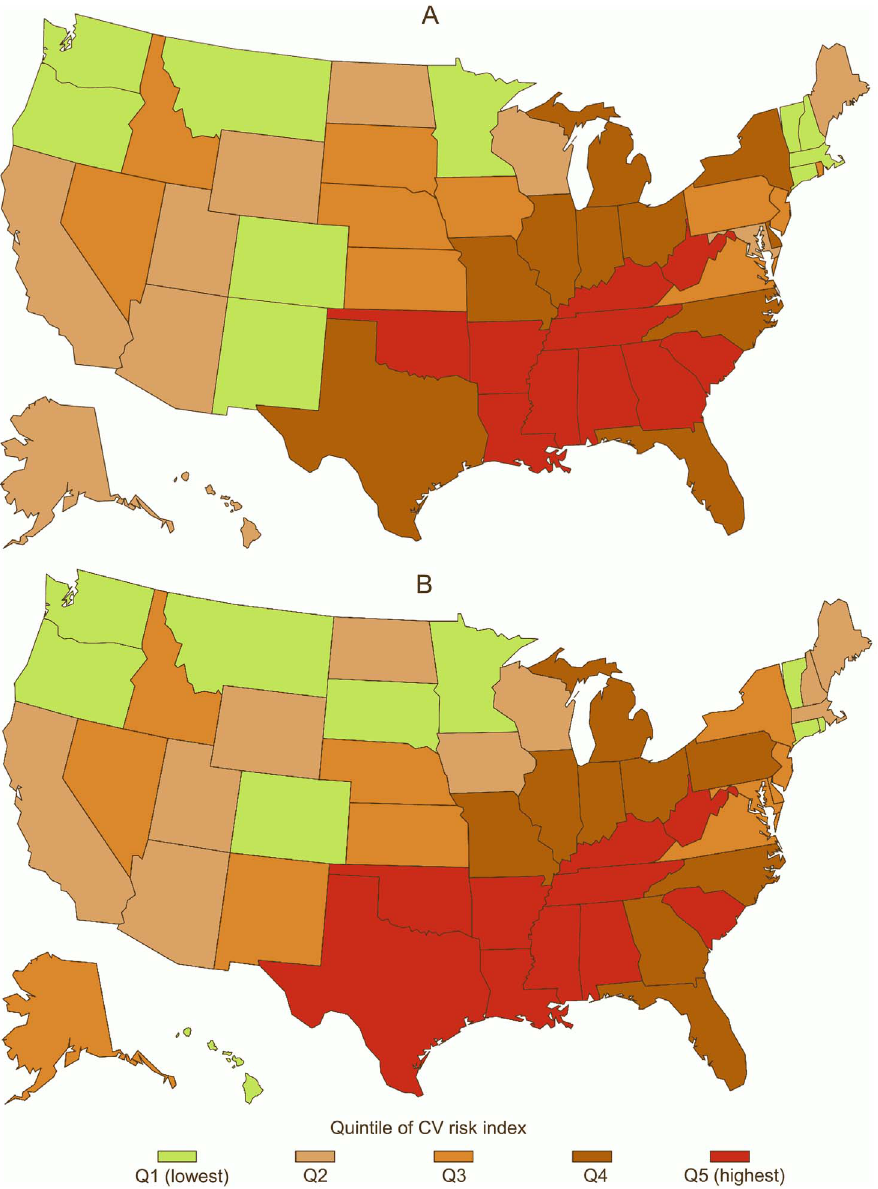
Figure 1. Geographical distribution of quintiles of state-level CV risk index among men (panel A) and women (panel B) aged 40–69 y in 2005 in the US. The CV risk index is a composite measure computed from principal components analysis of state-level risk factor prevalence data.